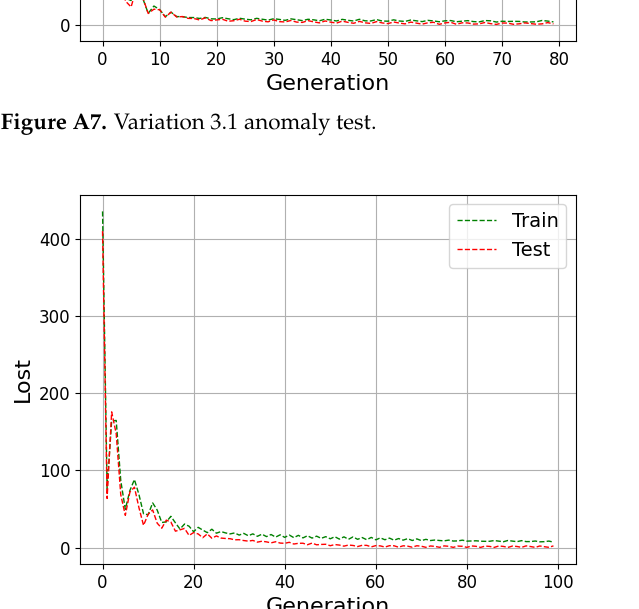
Figure A8. Variation 3.2 anomaly test.